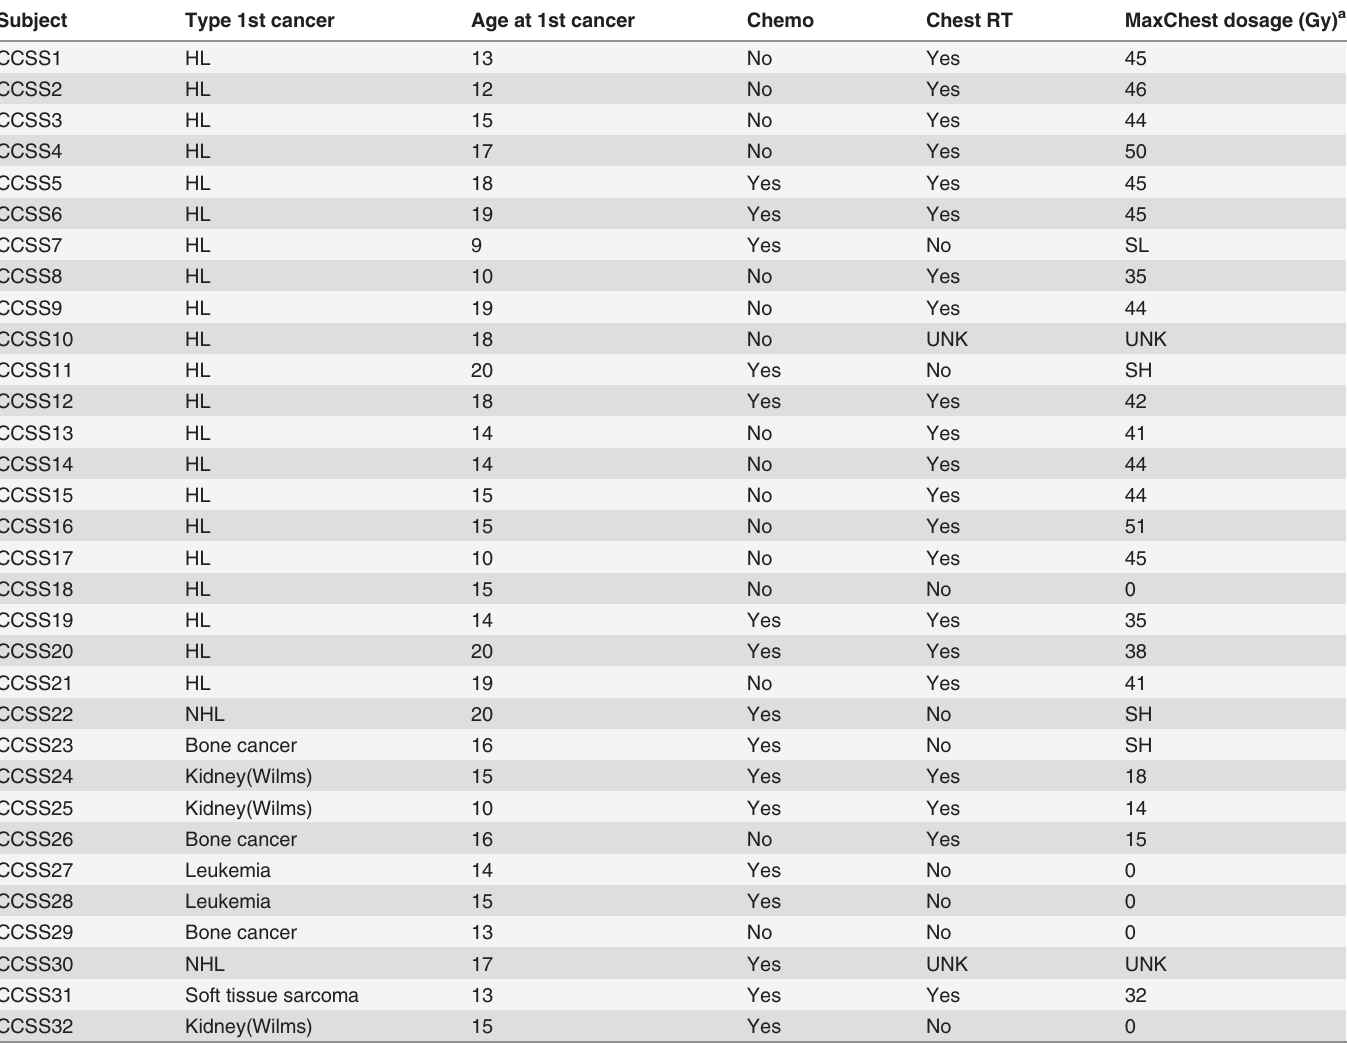
Table 1. Patient characteristics and treatment of CCSS cases included in this